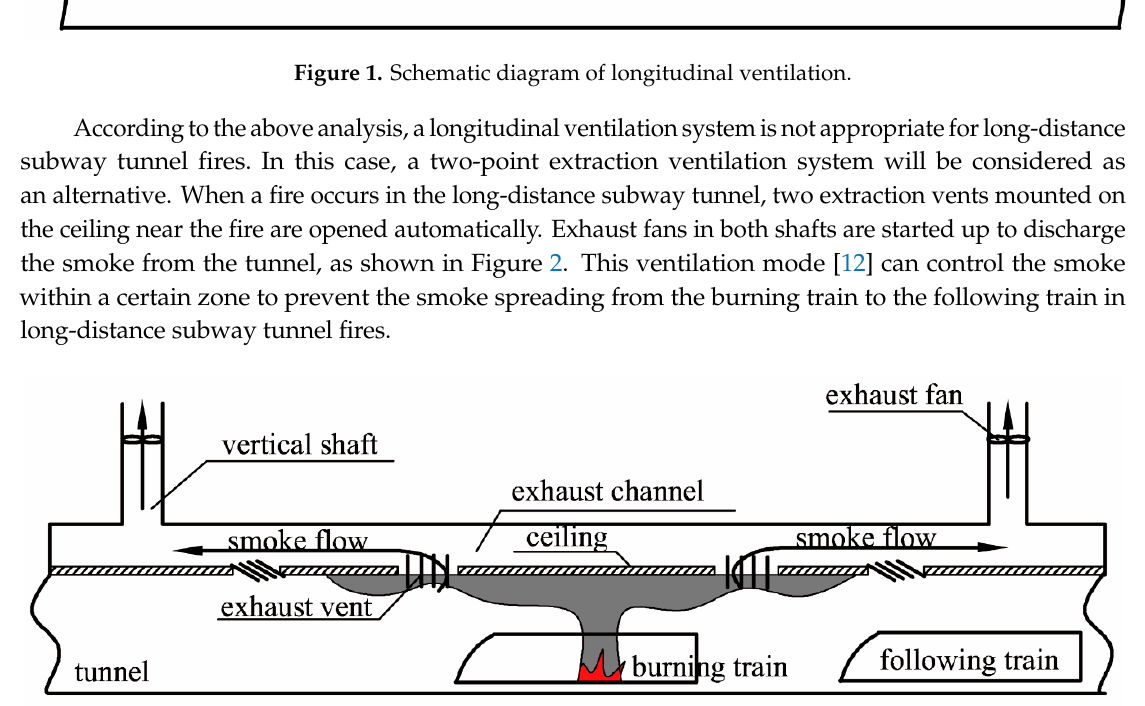
Figure 2. Schematic diagram of two-point extraction ventilation.